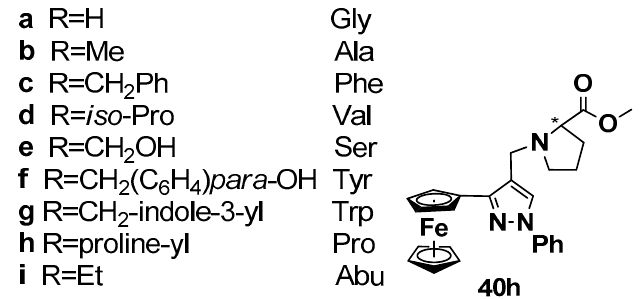
17 of 21 Figure 20. Structure of (3,5,5-trimethylhexanoyl)ferrocene . 7.3. Electrophysiological Investigations An electrophysiological direction is presented in works [71,72]. It was found that the introduction of ferrocene-modified amino acids (Figure 21) causes changes in synap- tic transmission in the CA1 region of the hippocampus. The hippocampus is a key brain structure involved in learning and memory processes. Local field potentials were meas- ured. A local field potential (LFP) is an electrophysiological signal generated by a summed electric current flowing from many neighboring neurons in a small amount of nervous tissue. The introduction of ferrocene-containing compounds 40a , L - 40b , and D - 40b , all good redox mediators, led to an increase in the amplitudes of local field po-